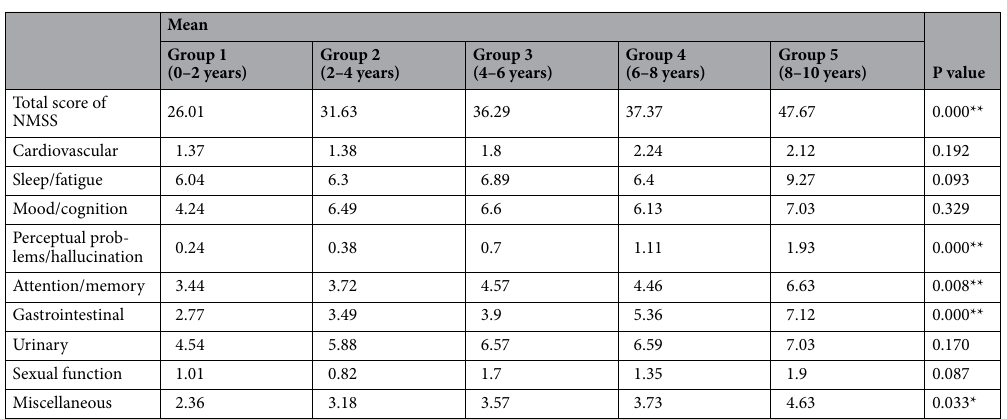
Table 2. Comparison of NMS severity in patients with a PD disease duration of less than 10 years. Group 1: 0 to 2 years (n = 142); group 2: 2 to 4 years (n = 194); group 3: 4 to 6 years (n = 166); group 4: 6 to 8 years (n = 114); group 5: 8 to 10 years (n = 60). The mean values of each group are shown in the left 5 columns, and the P values calculated using one-way analysis of variance are shown in the last column. Age and sex were corrected. * P < .05; ** P <